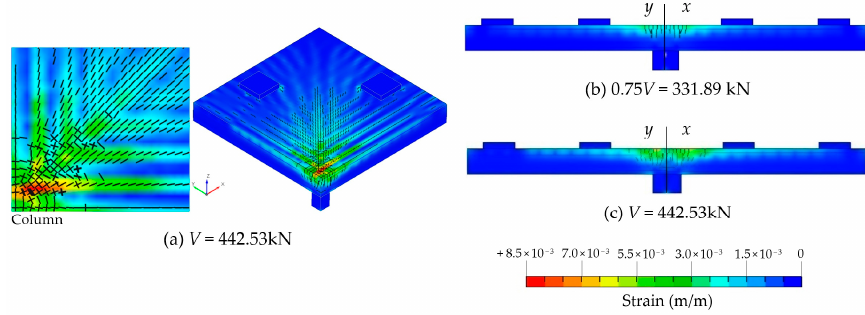
Figure 8. Cracking pattern on M1 model.